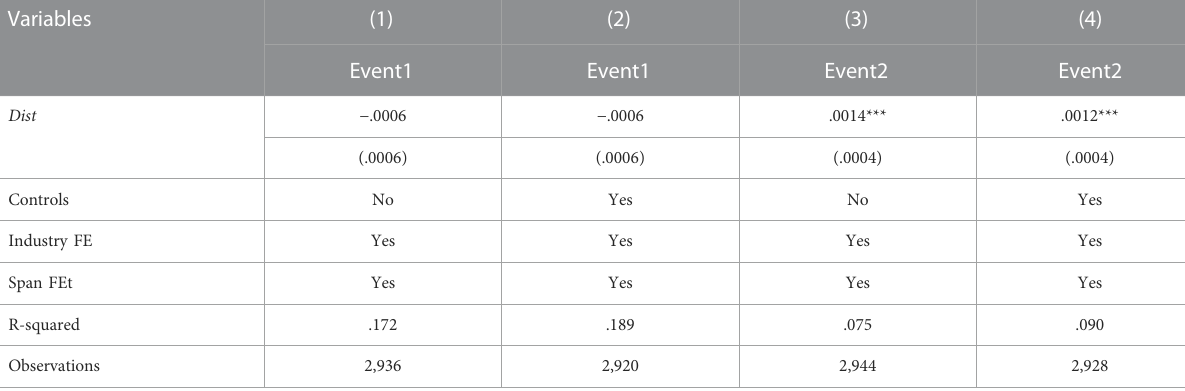
TABLE 7 Impact of distance on the CARs under Event 1 ( “ Bad News ” ) and Event 2 ( “ Good News ” ).